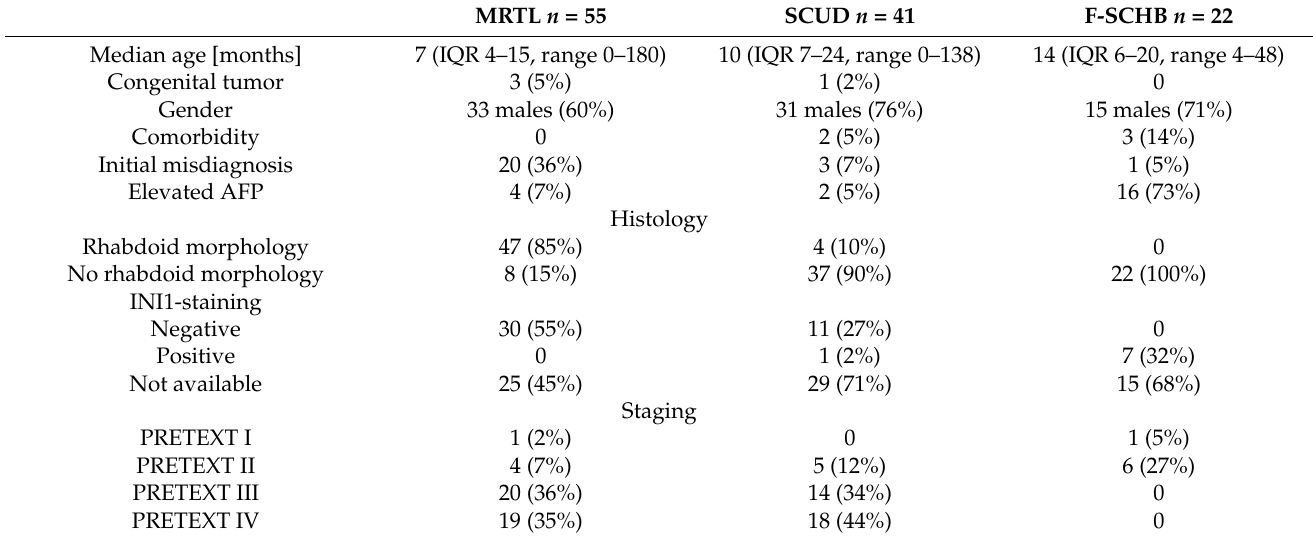
Table 1. Patient baseline